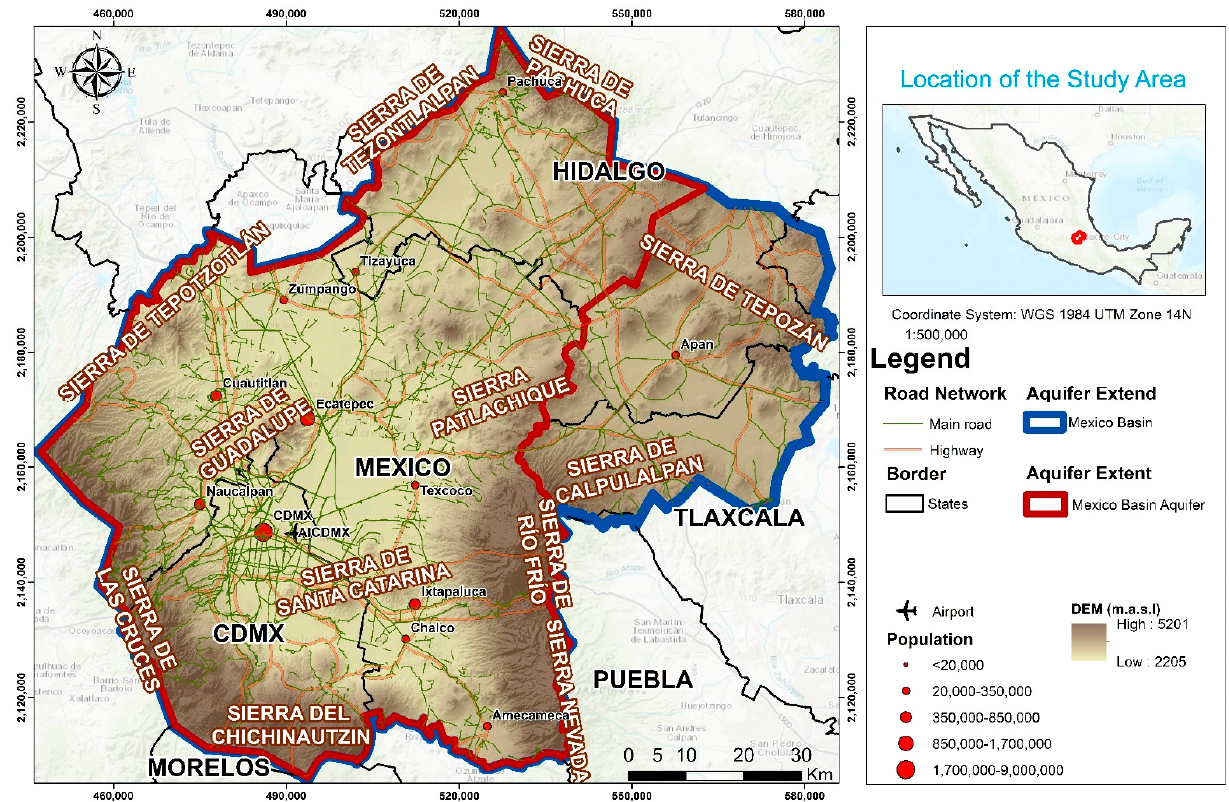
Figure 2. Study area, topography elevation and extent of Mexico Basin.